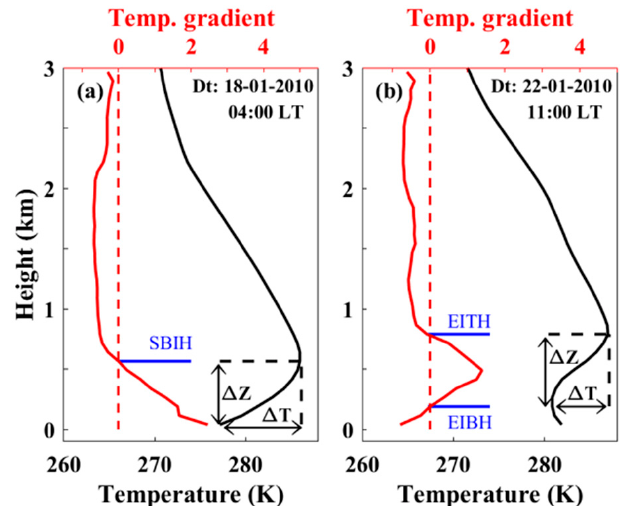
Figure 2. The vertical profile of temperature (black) and temperature gradient profile (red) observed on ( a ) 18 January 2010 at 04:00 local time and ( b ) 22 January 2010 at 11:00 local time ( b ) over the Southern Great Plains site. The blue lines represent the different height layers.